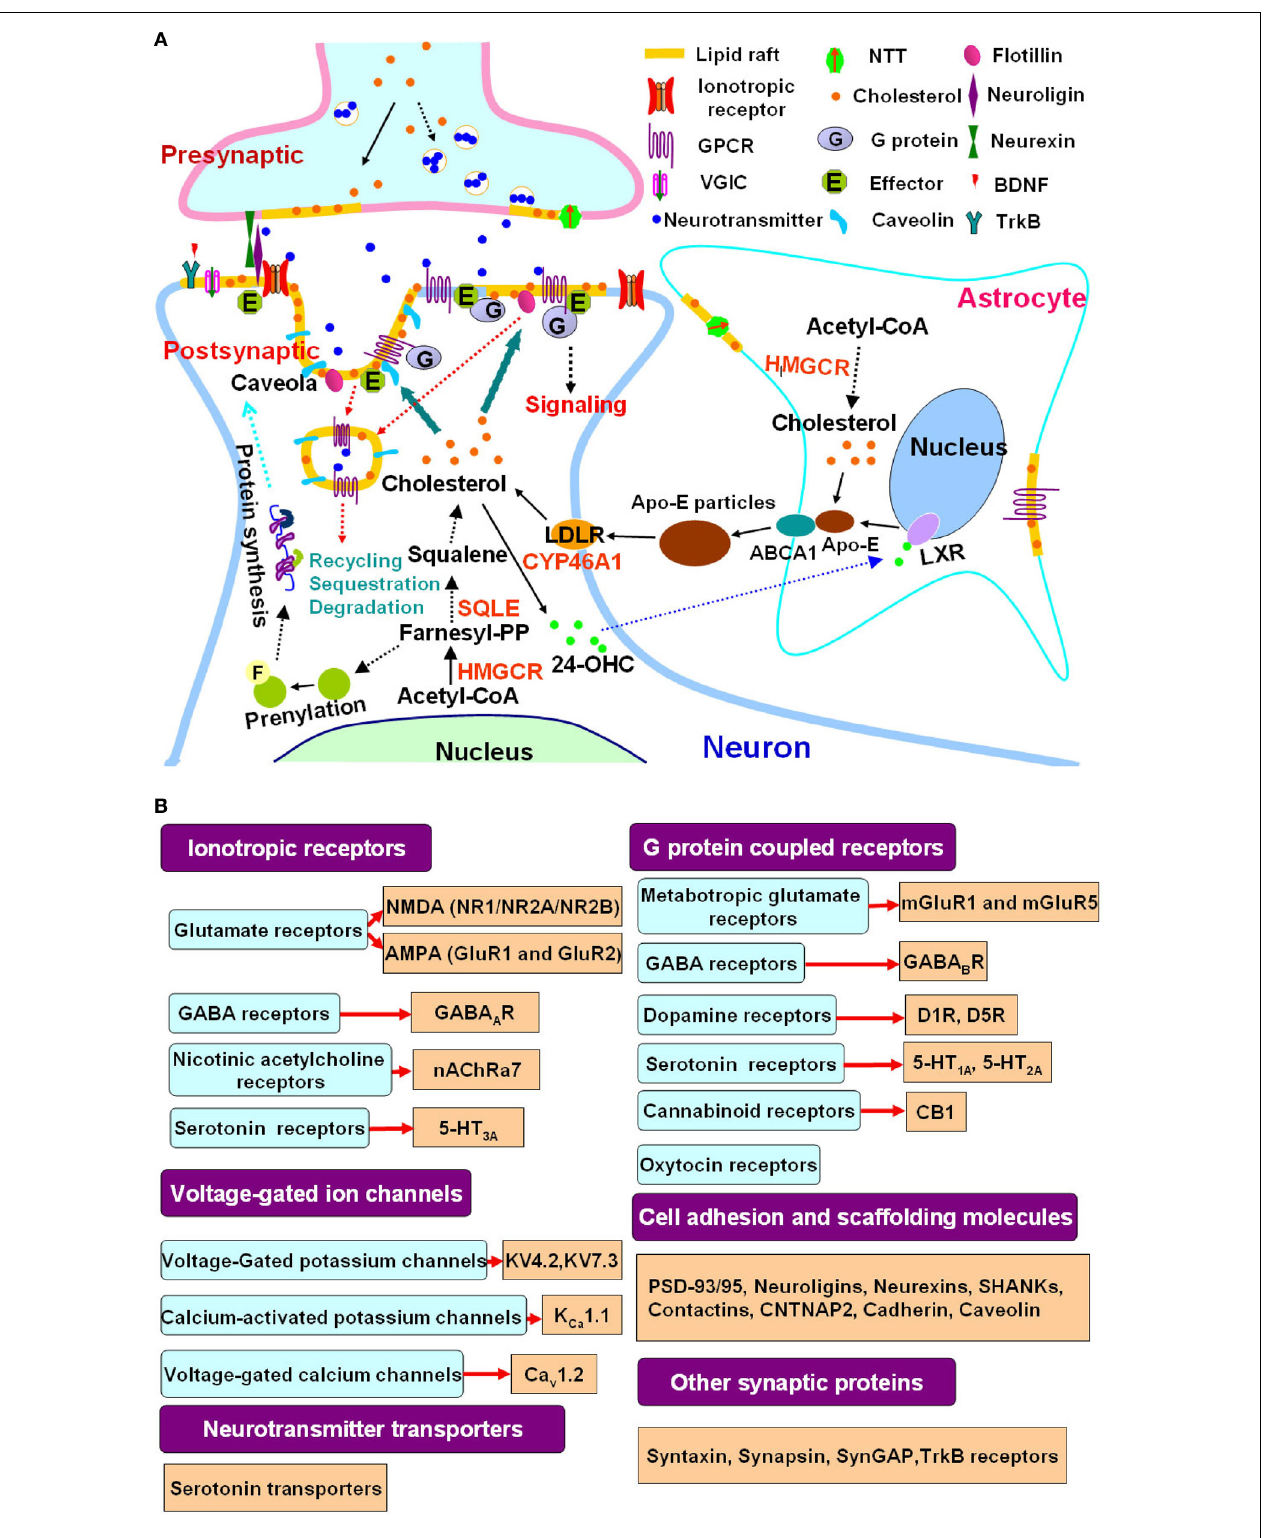
FIGURE 1 | Cholesterol metabolism, lipid rafts and autism spectrum disorders. (A) Lipid rafts link cholesterol metabolism to synaptic signaling. Cellular cholesterol is synthesized from acetyl-CoA in a multistep pathway, with HMGCR and SQLE as the rate-limiting enzymes. In the adult brain,